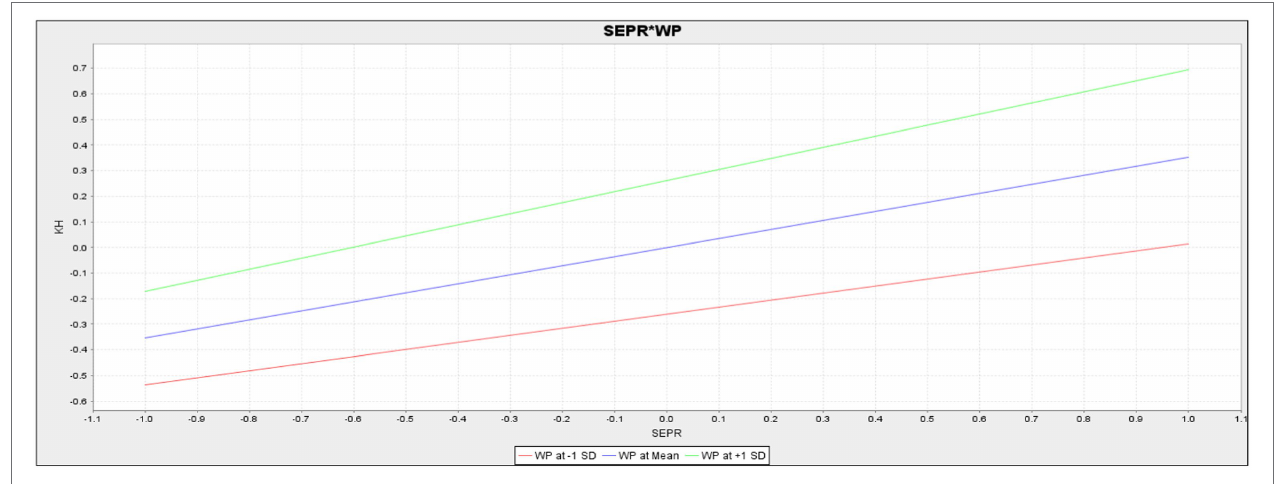
FIGURE 4 | A slope for lack of shared ethical priorities (SEPR) and